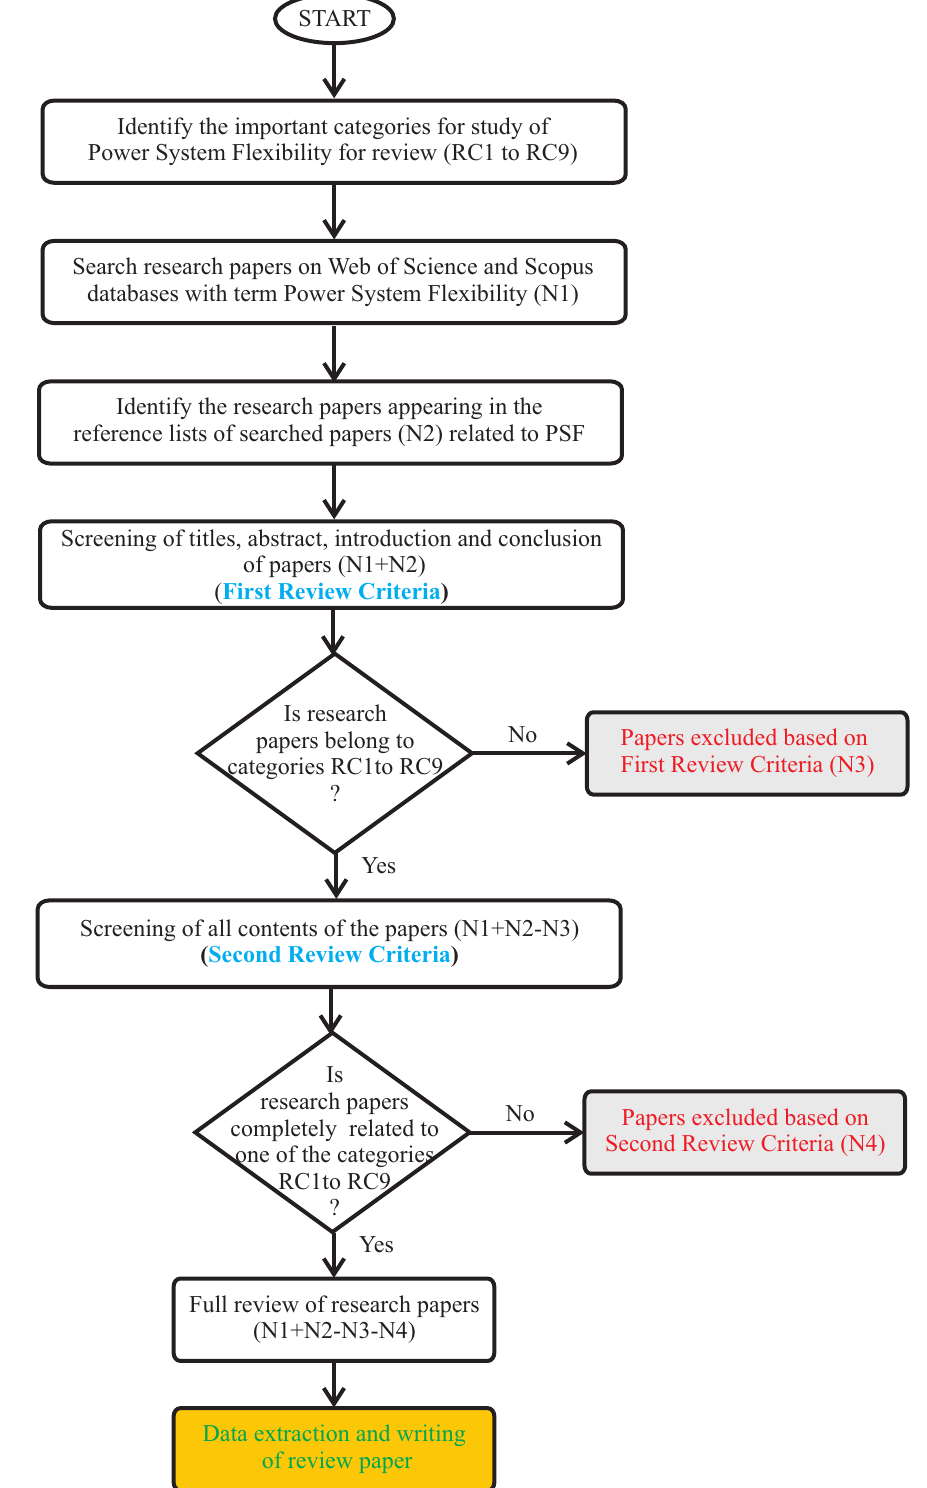
Figure 1. Review methodology used for the